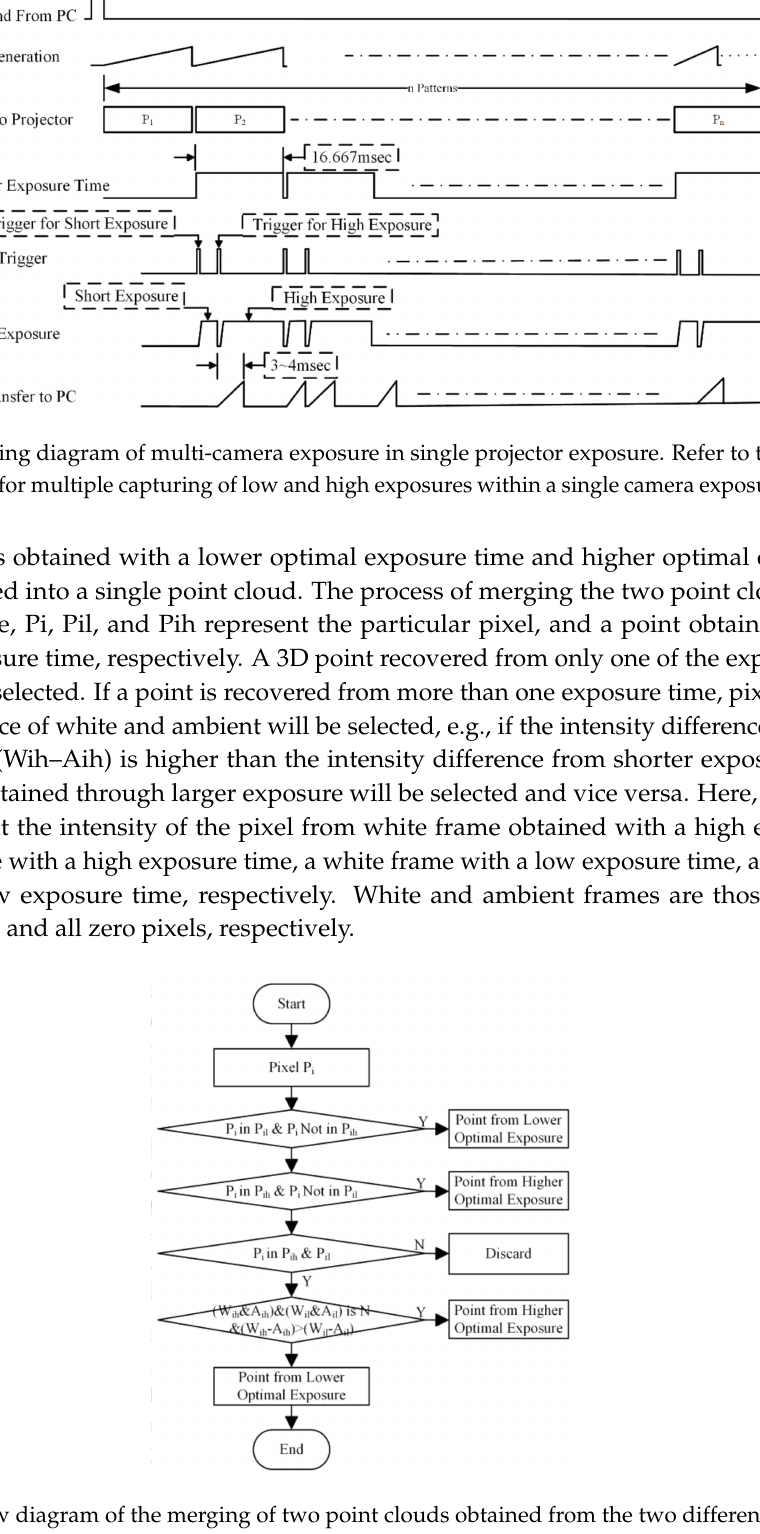
Figure 9. Flow diagram of the merging of two point clouds obtained from the two different exposure settings of the structured light 3D